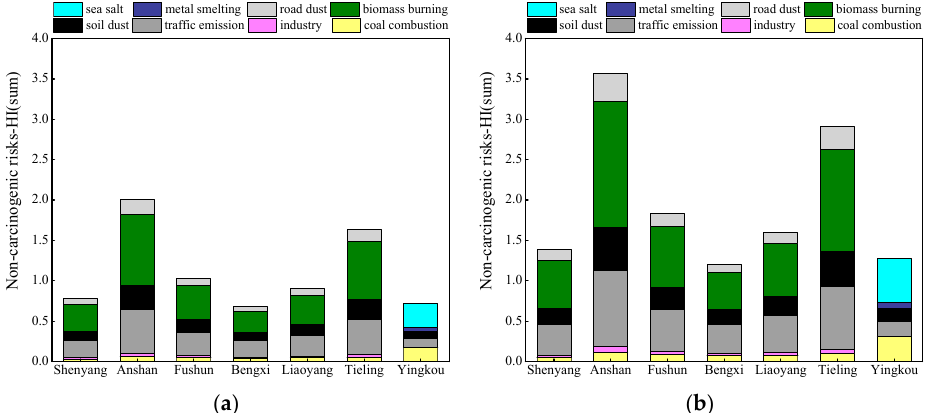
Figure 7. Non-carcinogenic risks (sum HI) to adults and children from the PMF-identified sources of PM 2.5 in seven cities (( a ) non-carcinogenic risks to adults and ( b ) non-carcinogenic risks to children). While the first six cities share the same sources, Yingkou is different from